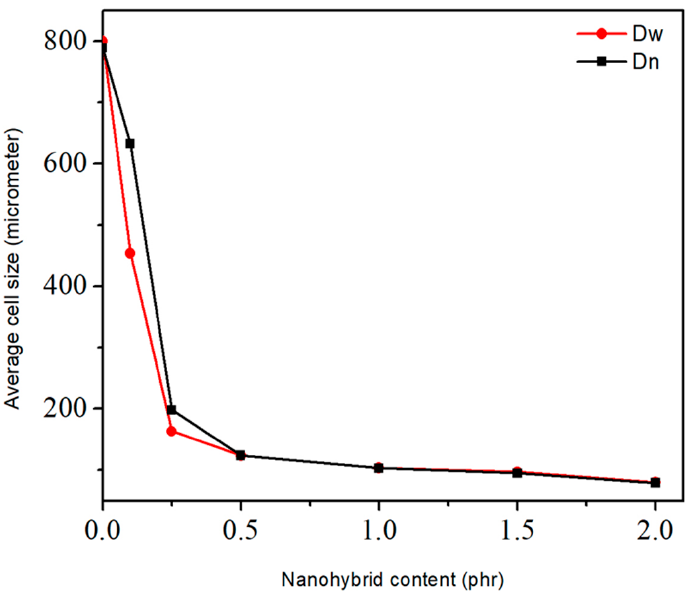
Figure 4. Variation of average cell size of NR/CNT/GNS foam nanocomposites versus . CNT/GNS hybrid content.